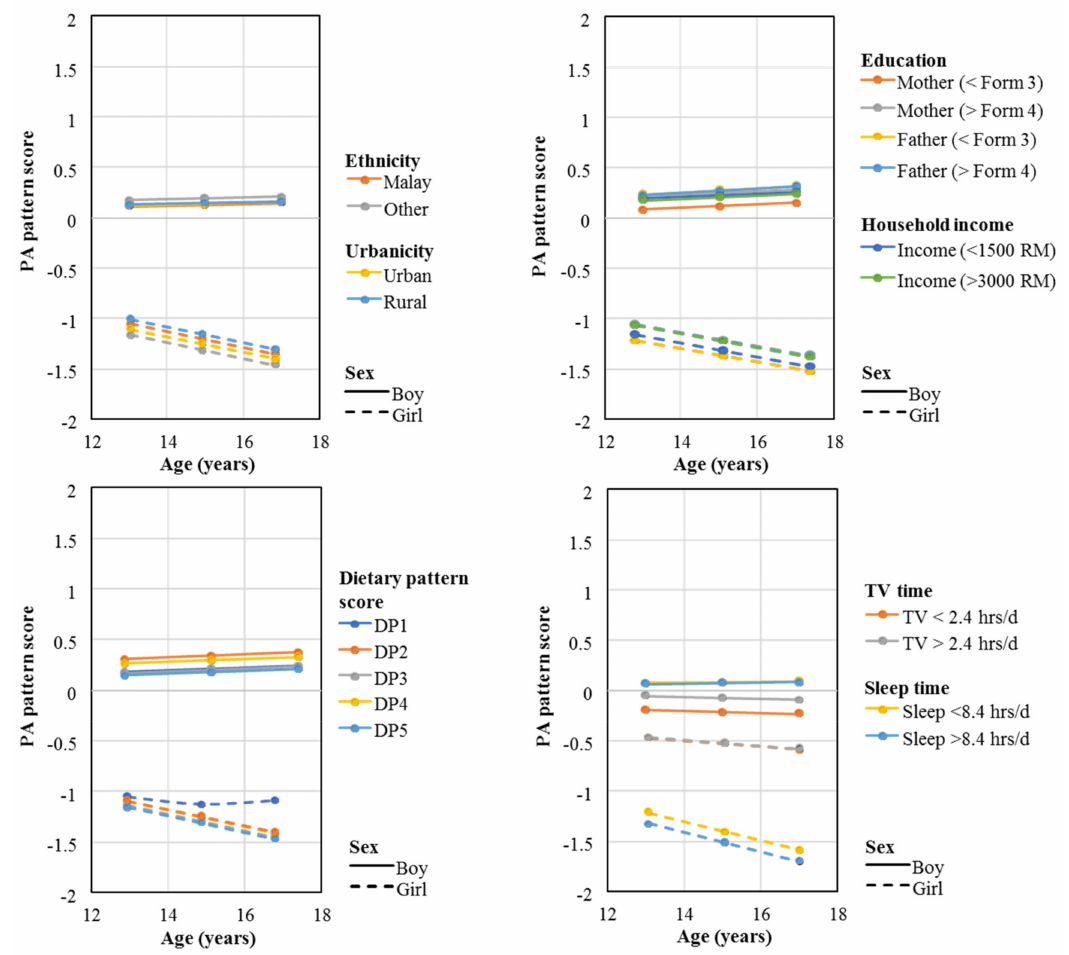
Figure 2. Average PA pattern score for di ff erent adolescent characteristics and by